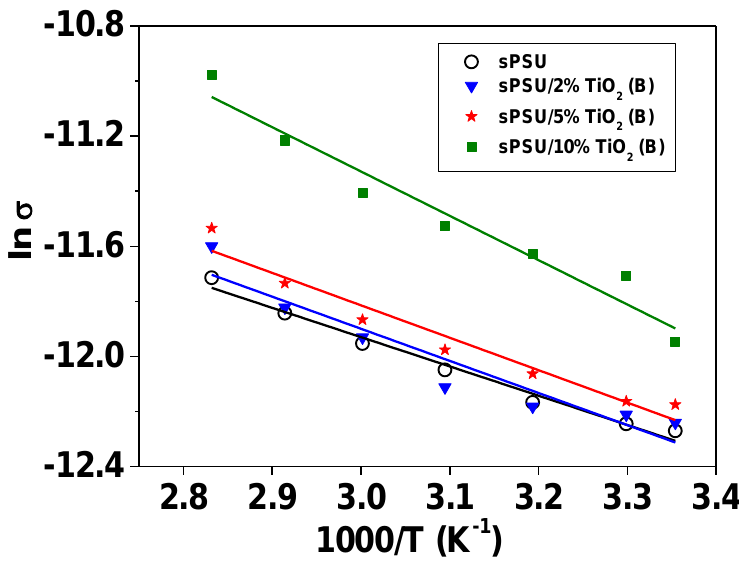
Figure 10. Evolution of proton conductivity with temperature for to the different sPSU/x%TiO 2 (B) composite membranes (x = 2; 5 and 10).